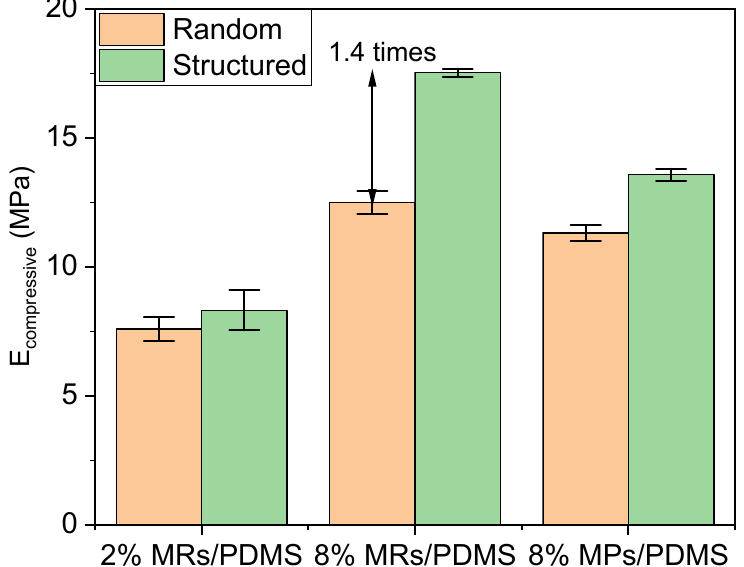
Figure 10. Compressive elastic modulus for different random and structured (i.e., aligned) ZnO MR/PDMS and MP/PDMS composites.